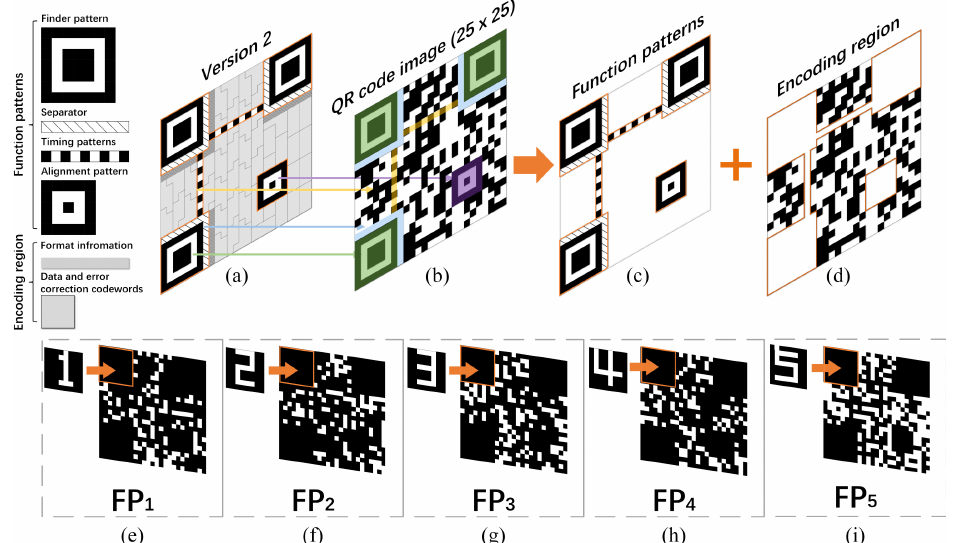
Figure 2. Schematic of QR code image segmentation and watermark embedding for the t = 4 case.